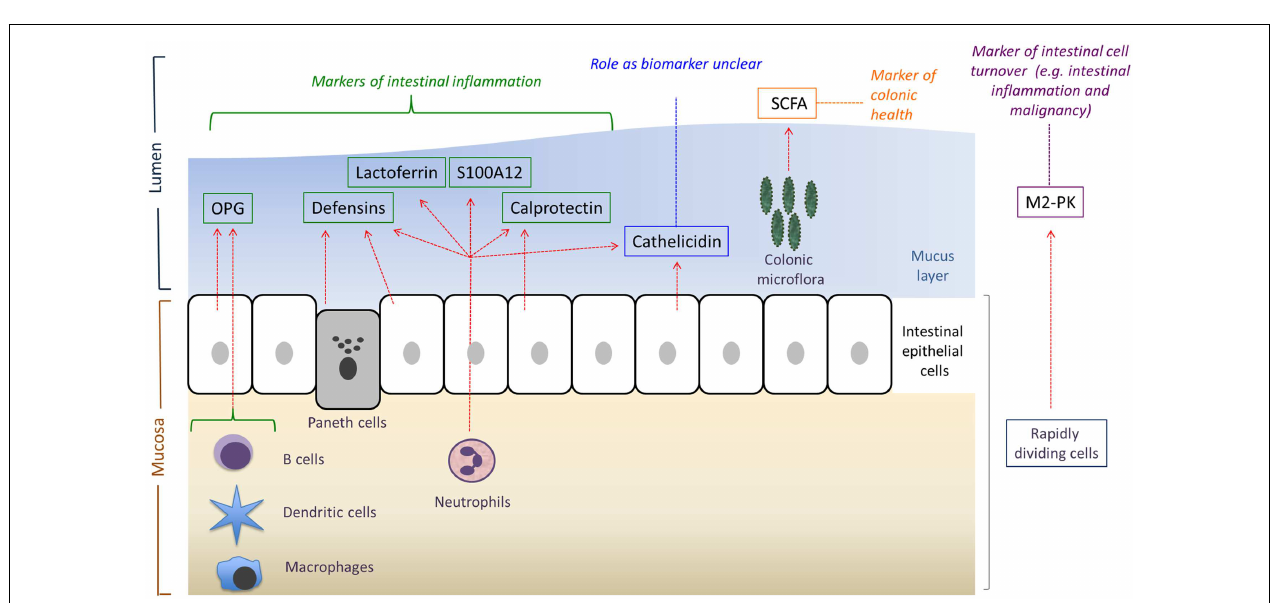
FIGURE 1 |An overview of the main sources and potential uses of the various fecal biomarkers reviewed in this article . OPG, osteoprotegerin; SCFA, short-chain fatty acids; M2-PK, M2-pyruvate kinase. Adapted from Ref. (12).